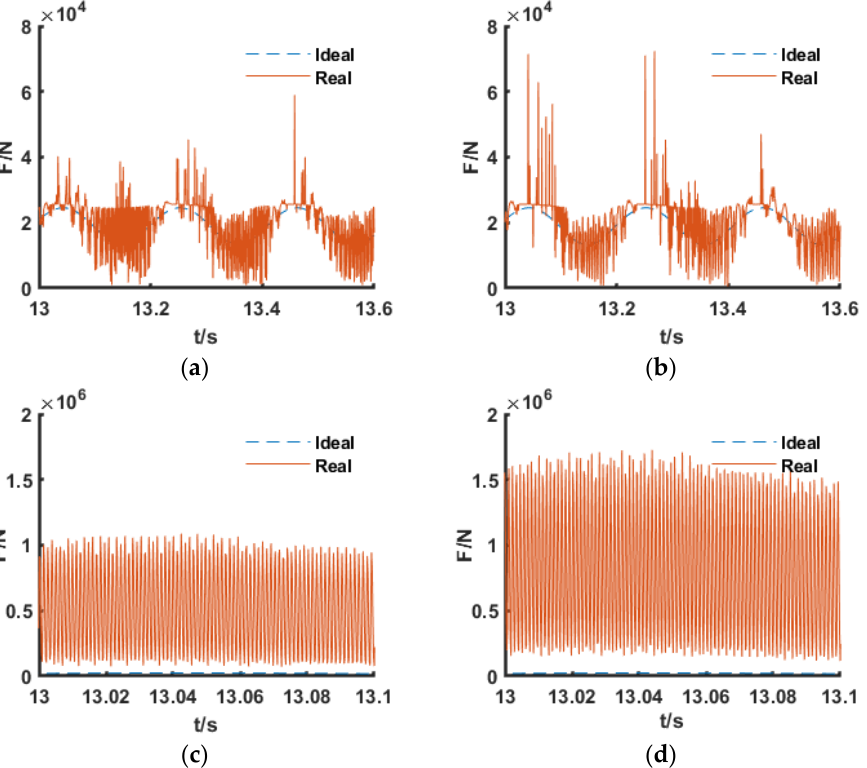
Figure 12. Vibration force on the foundation at different clearance sizes. ( a ) 𝑟 = 0.03 . ( b ) 𝑟 = 0.06 . ( c ) 𝑟 = 0.09 . ( d ) 𝑟 = 0.12 .